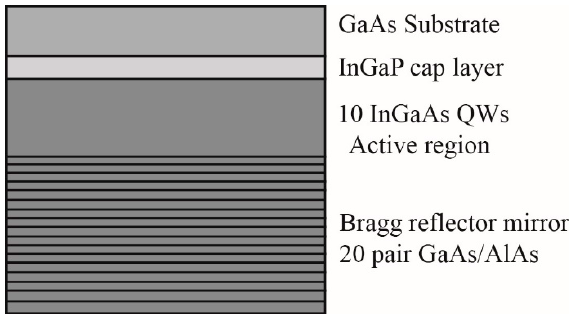
Figure 1. Schematic diagram of the designed semiconductor disk laser (SDL).